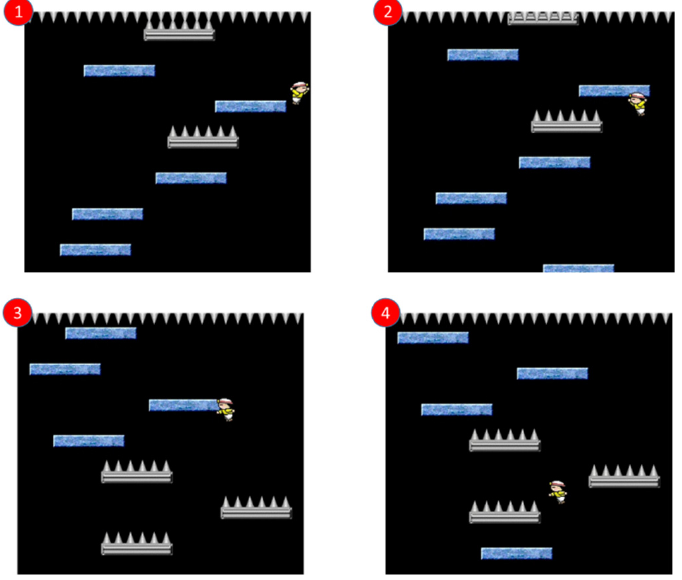
Figure 22. Actual game screen marked 1, 2, 3, and 4 in the trend graph of maximum Q value.